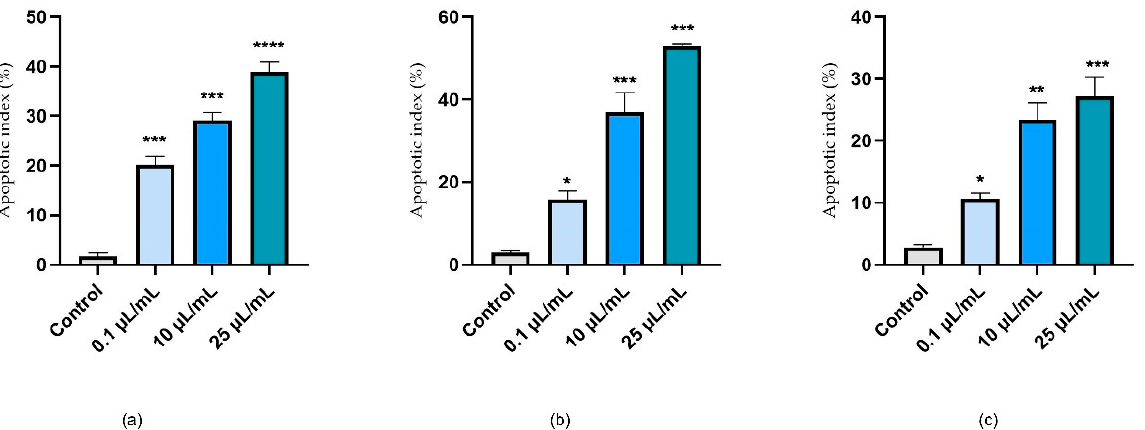
Figure 8. An analysis of the apoptotic index (AI) of HaCaT ( a ); HepaRG ( b ), and H9C2(2-1) ( c ) fol- lowing 24 h of nicotine treatment (0.1, 10, and 25 μ L/mL). Data are presented as an apoptotic index (%) normalized to controls and expressed as mean values ± SD of three independent experiments. The statistical differences between sontrols and the treated group were verified by apply- ing a one-way ANOVA, followed by Dunnett’s multiple comparisons post-test (* p < 0.1; ** p < 0.01; *** p < 0.001; **** p <